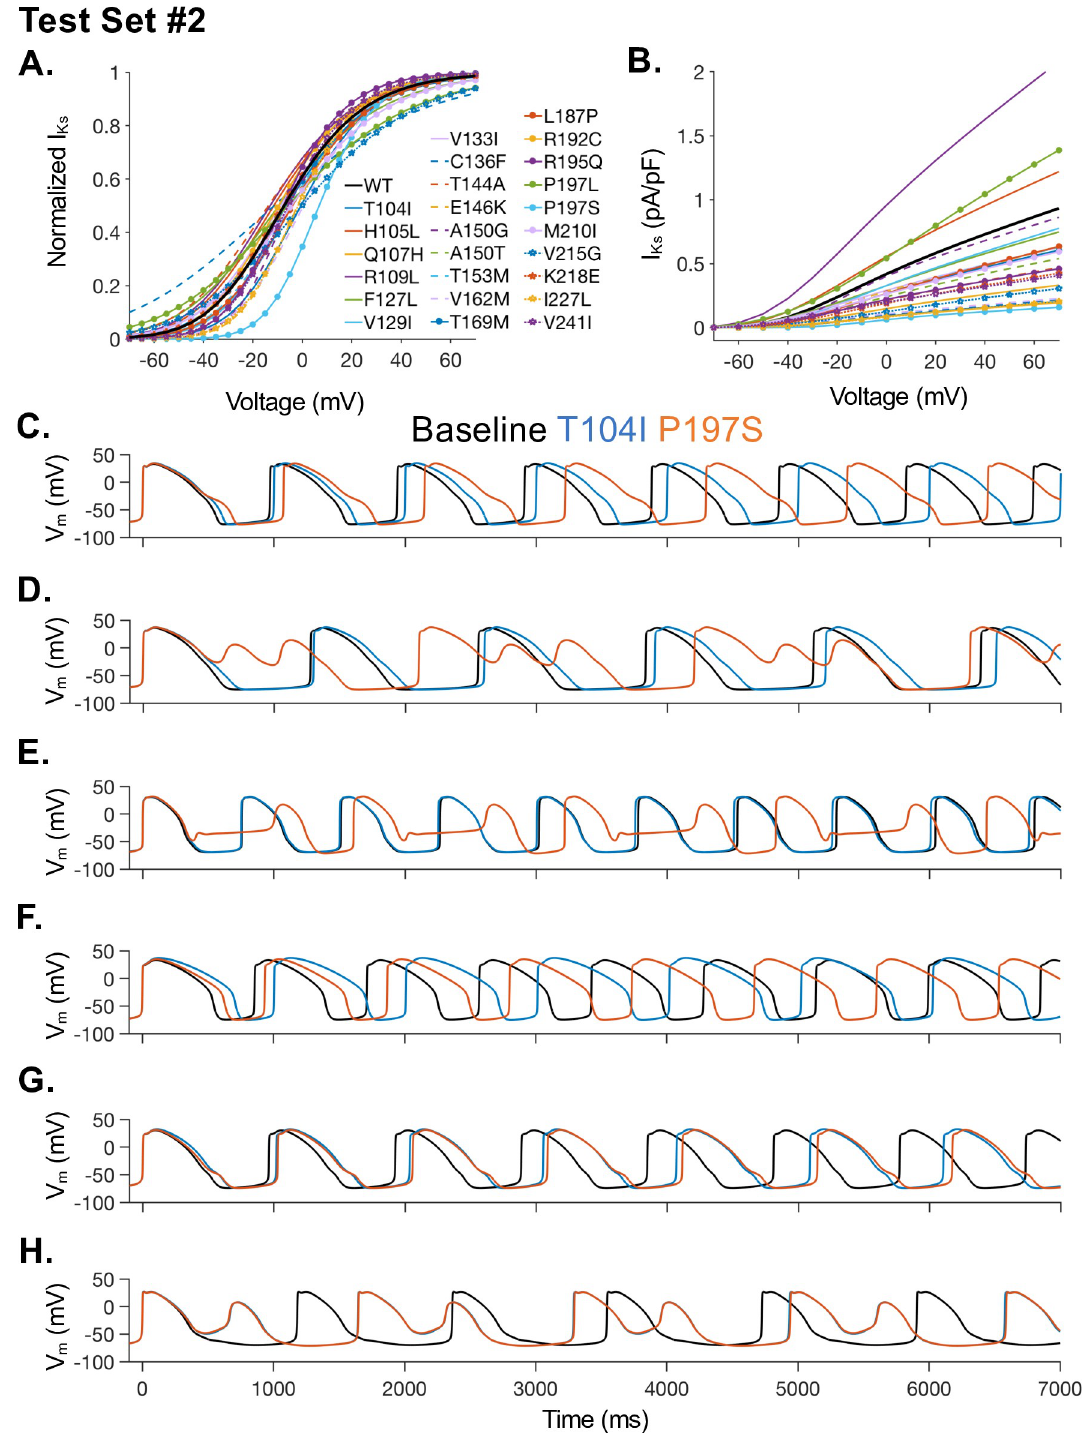
Fig 4. Model optimization for test set 2 (TS2) and sample APs comparing selected mutations in TS2. (A) Steady-states activation and (B) IV relationships resulting from optimization of the iPSC-CM I Ks model to fit experimental results for TS2 mutations. (C-H) Wild-Type (black), T104I mutant (blue), and P197S mutant APs are shown for several sample iPSC-CM models within our population. Mutations were selected to demonstrate the greatest average APD 90 prolongation (T104I) and greatest average increase in triangulation (P197S) in TS2. (C-E) A selection of computational models from the population that showing more impact of the P197S mutation than the T104I mutation. (F) One computational model from the population responds to the T104I mutation with more